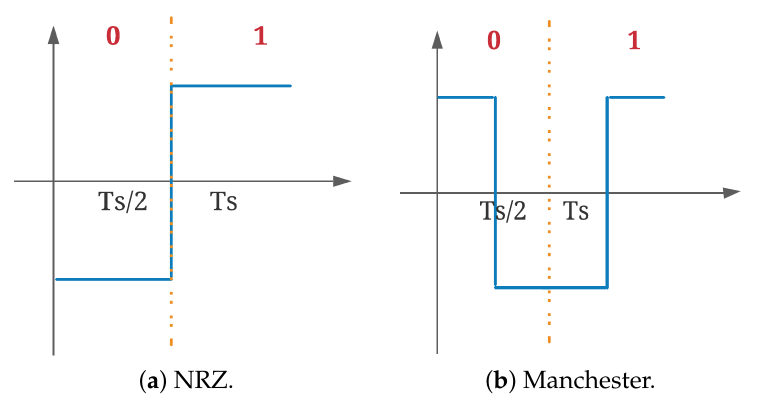
Figure 2. Type of